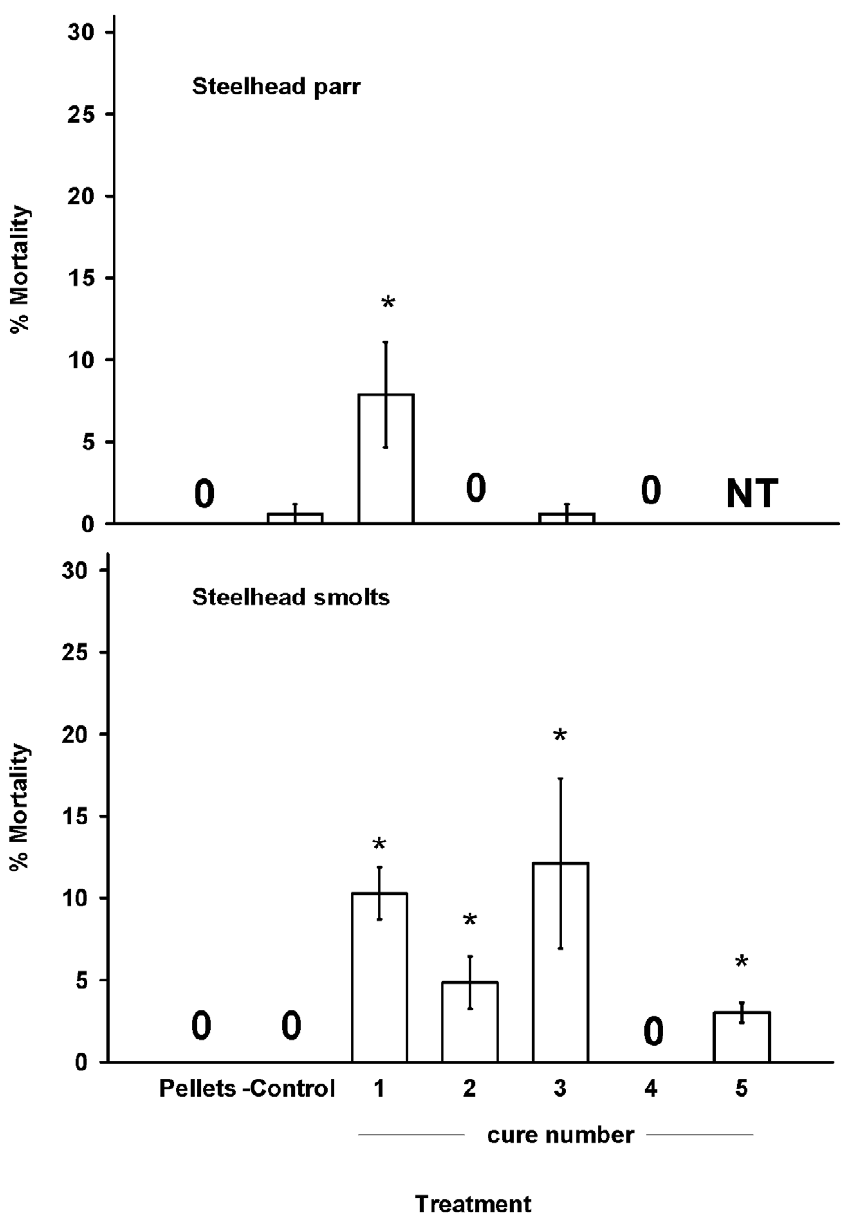
Figure 1. Juvenile steelhead parr and smolt mortality. Juvenile steelhead parr or smolts were fed for 23 d with pellets, salmon eggs (- control), or salmon eggs cured with 1 of 4 or 5 commercially available cures. Bars represent the mean % mortality for three replicate tanks (N=55 fish per tank). A value of 0 represents treatments that had no mortality in all three tanks. NT=Not Tested *Significantly different from the group fed pellets ( P ,